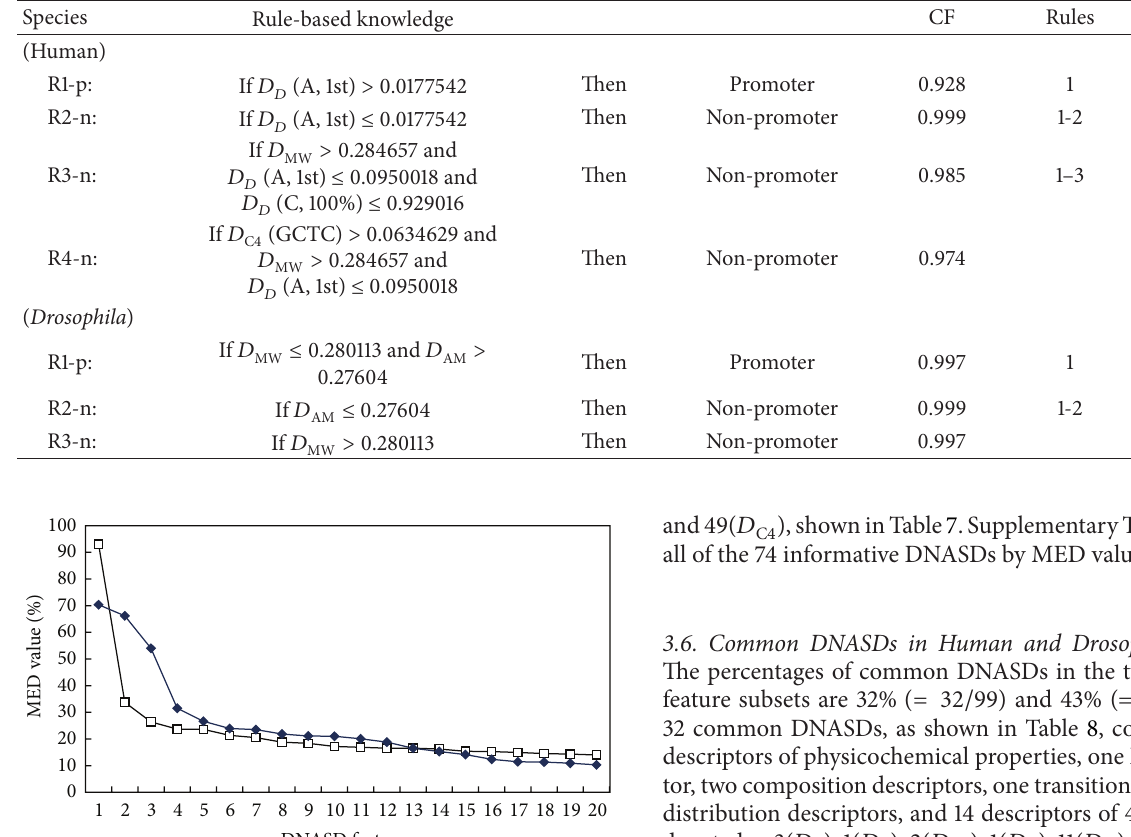
Table 7: The rule-based knowledge of promoter prediction in human and Drosophila species.